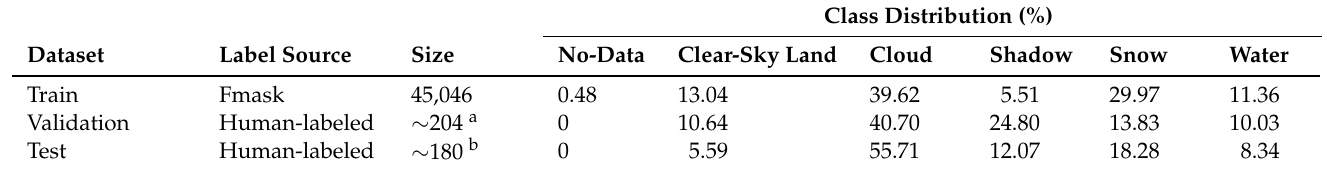
Table 4. Class distribution of the datasets used for training and validation of the model. The size of each dataset is quantified as the number of 254 × 254 image